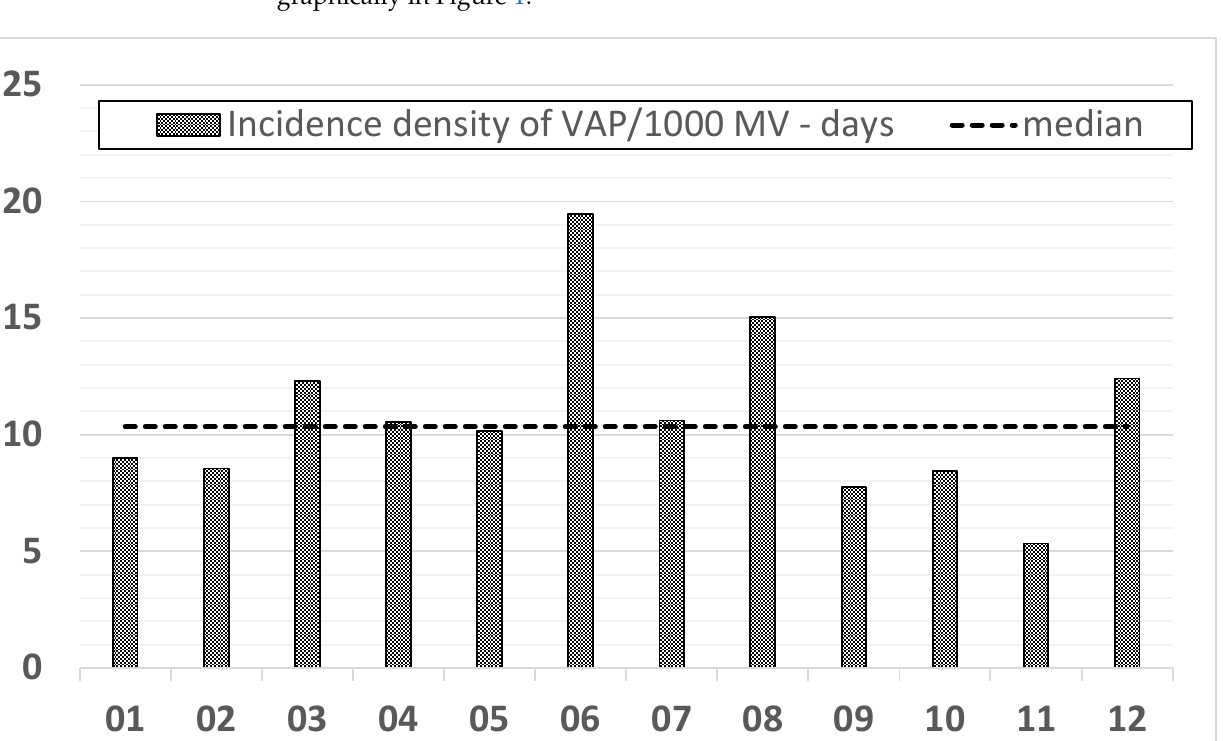
Figure 1. Incidence density of VAP/1000 ventilator days in the following months of 2018. The most common CAP pathogen was methicillin-sensitive Staphylococcus aureus (MSSA), which was responsible for 18/34 (53%) of infections. Acinetobacter baumannii was the most common pathogen of nosocomial pulmonary infections. Acinetobacter baumannii was multidrug-resistant (MDR) and Klebsiella pneumoniae had extended-spectrum